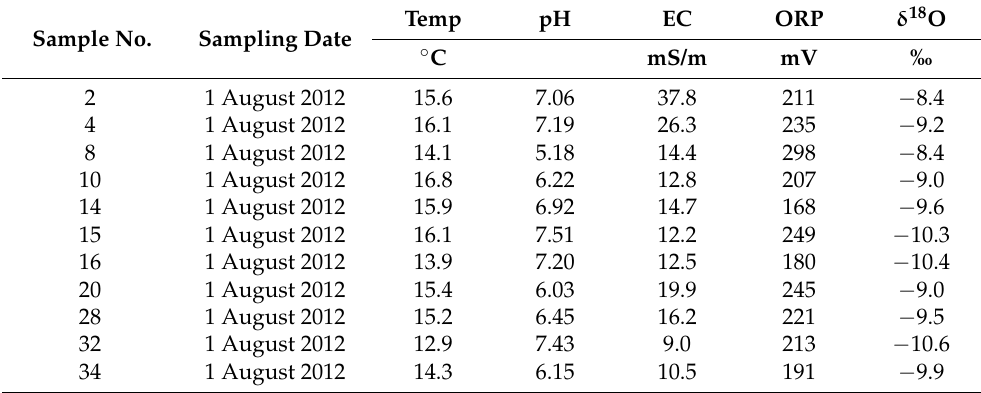
Table 6. Water temperature, pH, electric conductivity (EC), oxidation–reduction potential (ORP), and δ 18 O composition for groundwater samples in the Sho River alluvial fan on 1 August 2012.